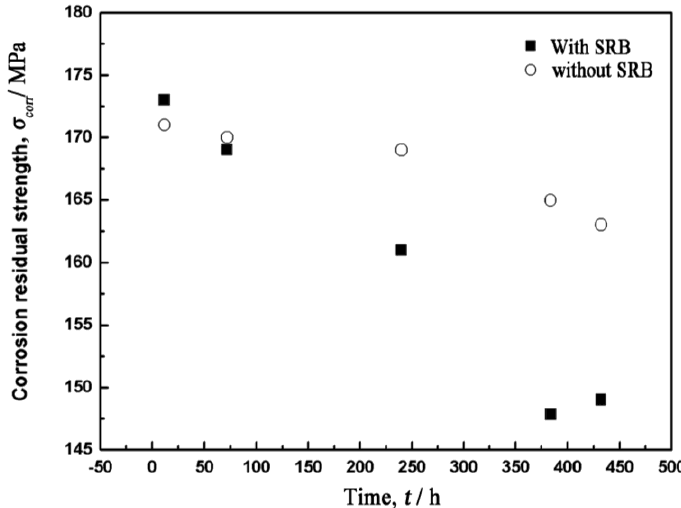
Figure 3. The corrosion residual strength of the AZ91D magnesium alloy in the presence of SRB drops faster than in the absence of SRB.